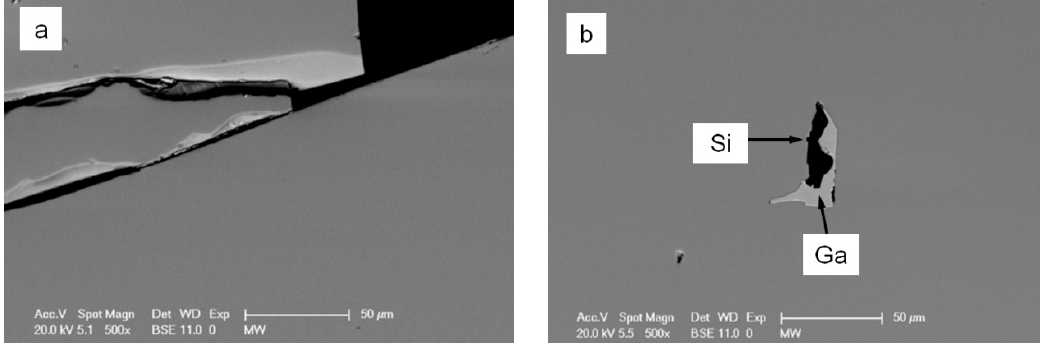
Figure 5. Scanning electron microscope (SEM) images for samples ( a ) L (left) and ( b ) S (right). The main phase (grey color) in both samples is clathrate; the light grey phase in the S sample (right) is Ga (inclusion) and the black phase is Si.